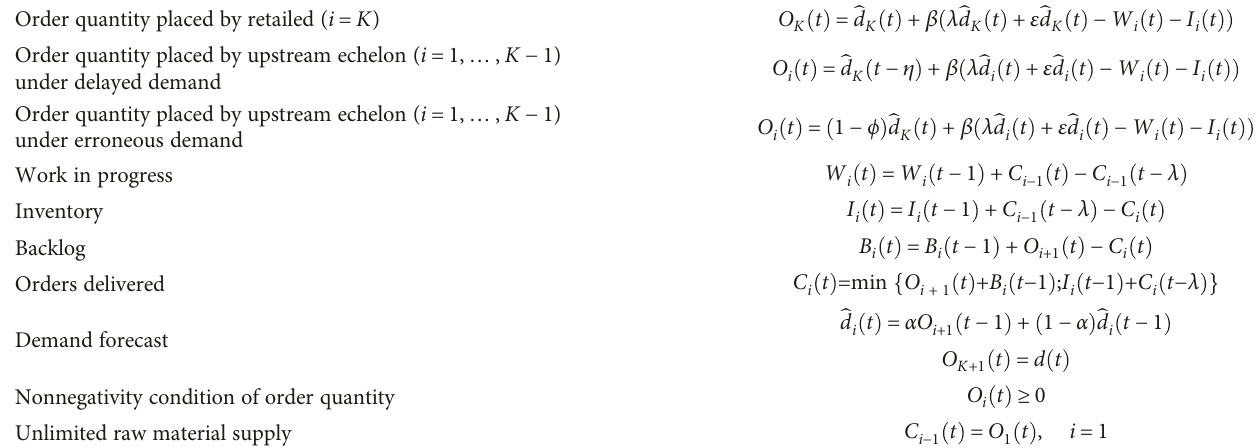
Table 4: Mathematical model.